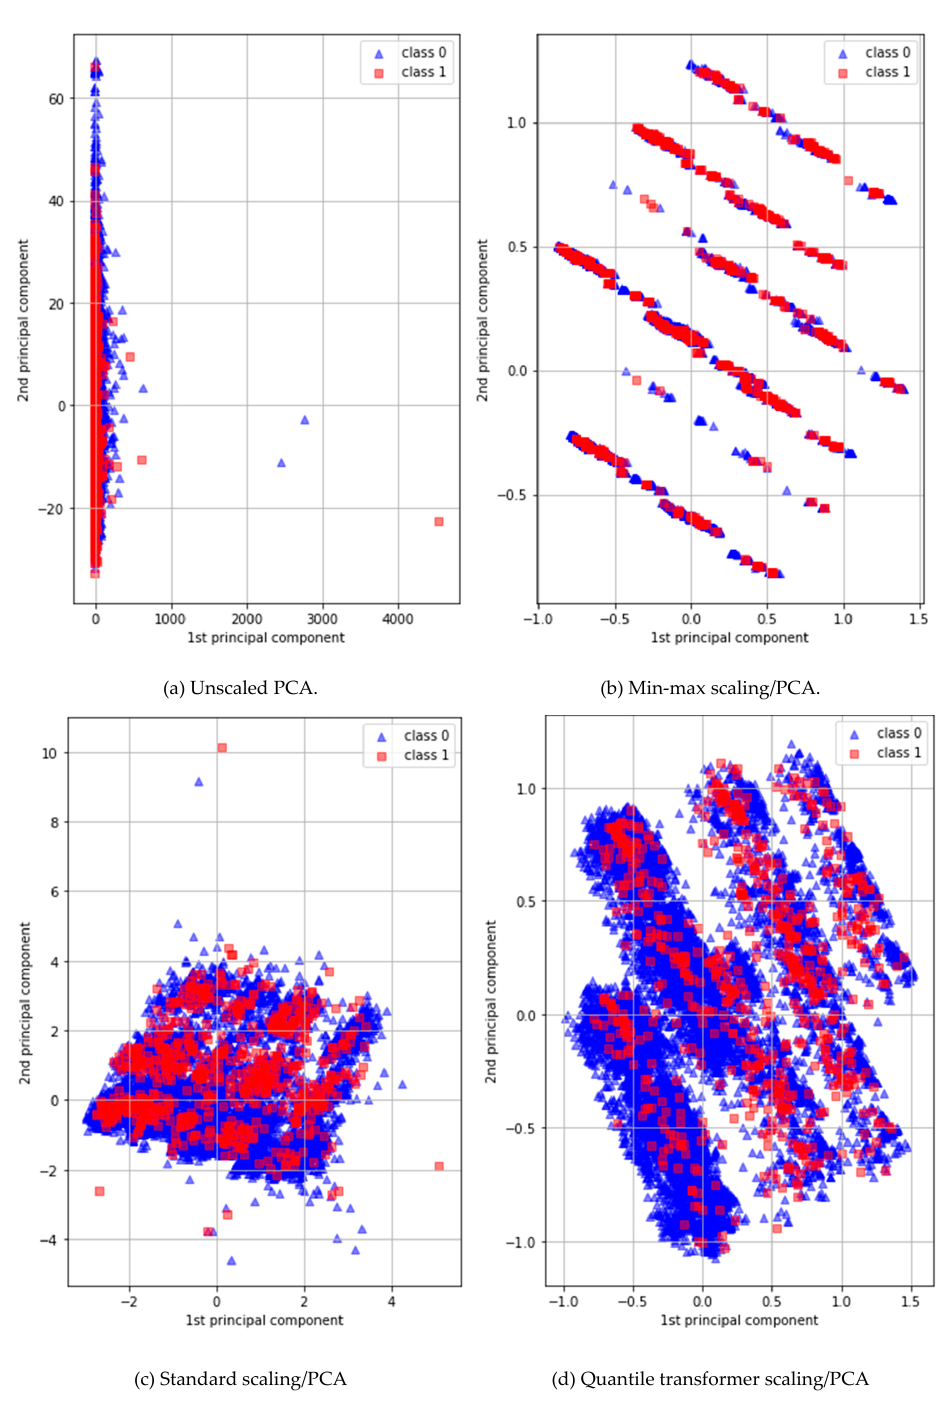
Figure 3. Two-dimensional plots of the first and second principal components (class 0 indicates non-stroke patients and class 1 indicates stroke